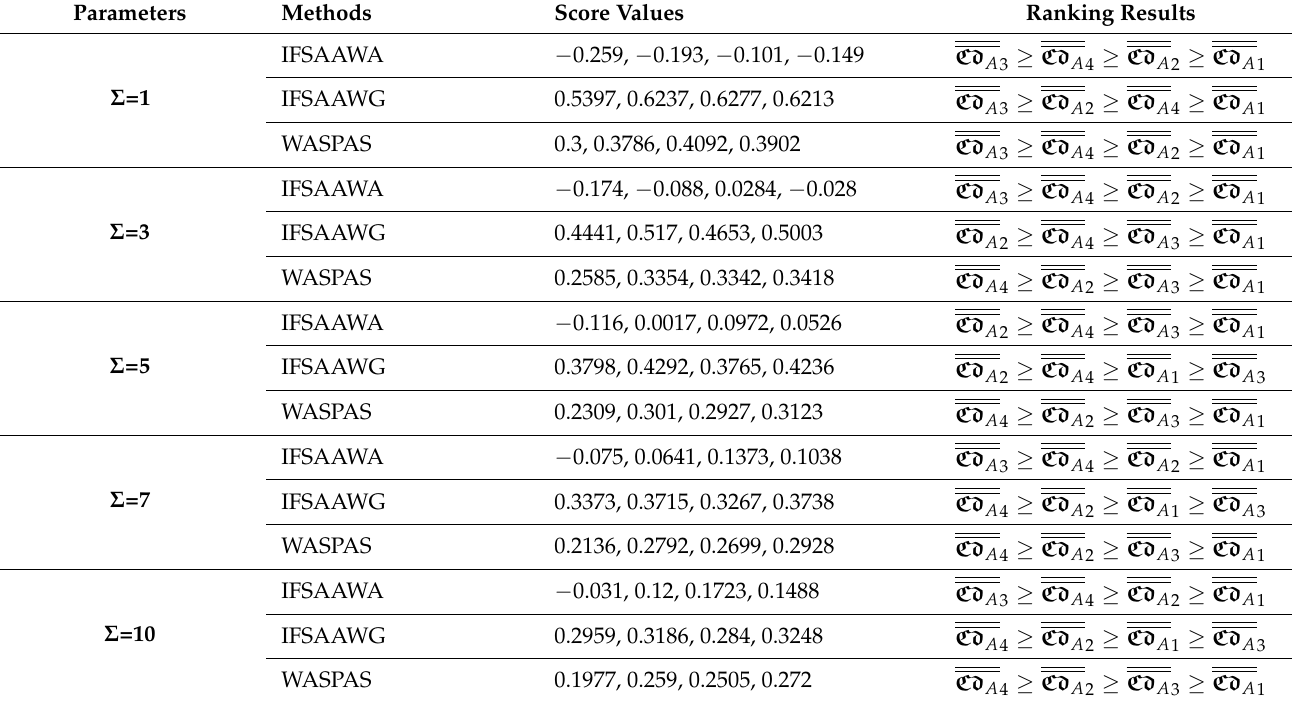
Table 8. Analysis of parameters for different